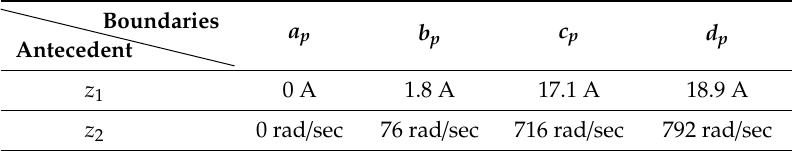
Figure 2. Membership function of the IT2 T-S fuzzy control systems. Table 1. Antecedent variables and boundaries of the PMSG.